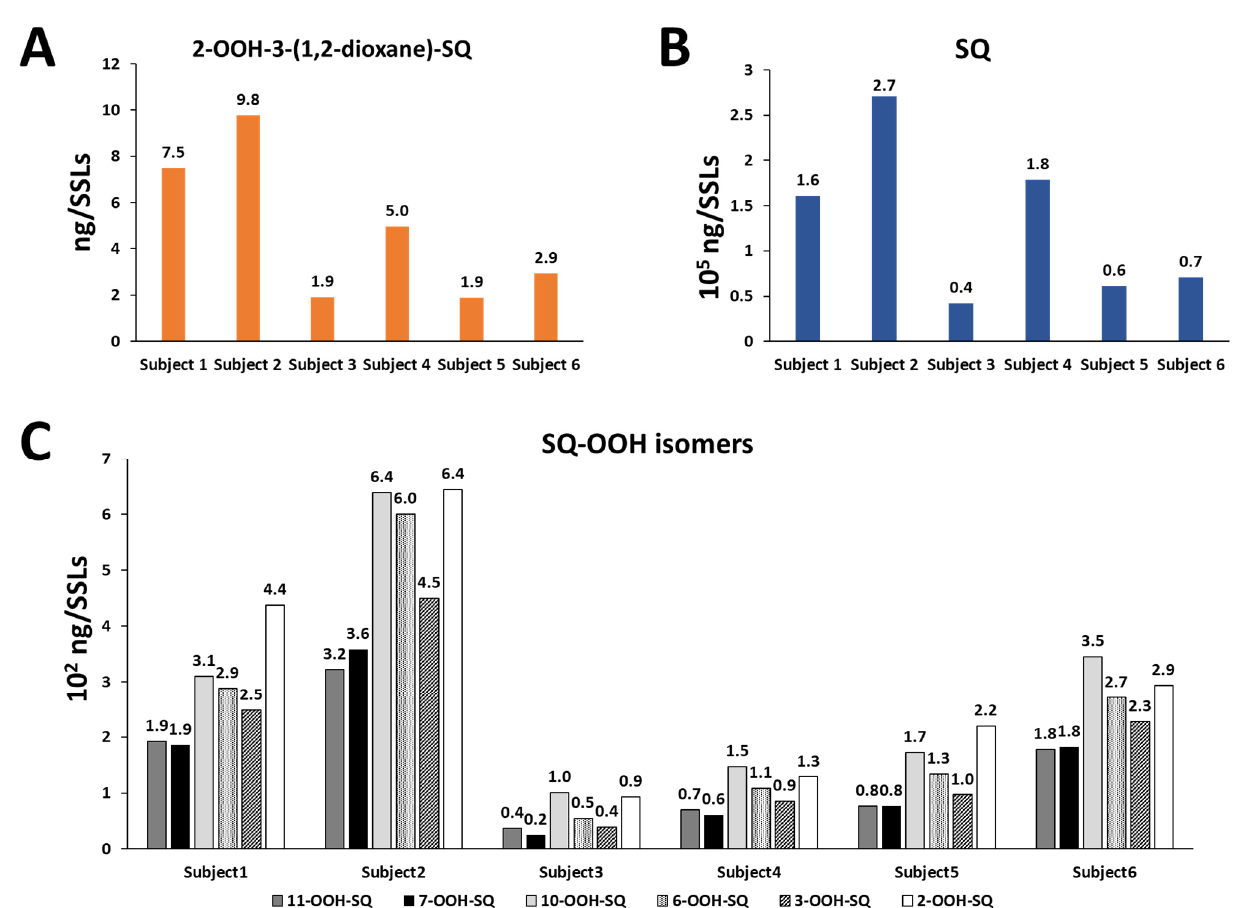
Figure 9. Quantities of 2-OOH-3-(1,2-dioxane)-SQ ( A ), of SQ ( B ), and of SQ-OOH isomers ( C ) in SSLs of six healthy individuals calculated by the use of external standards using HPLC ‐ MS/MS.